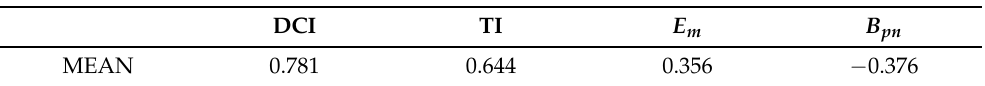
Table 2. Average of the error indices on the slices of all the CT exams of the patients taking part in the study. DCI TI E m B pn MEAN 0.781 0.644 0.356 −